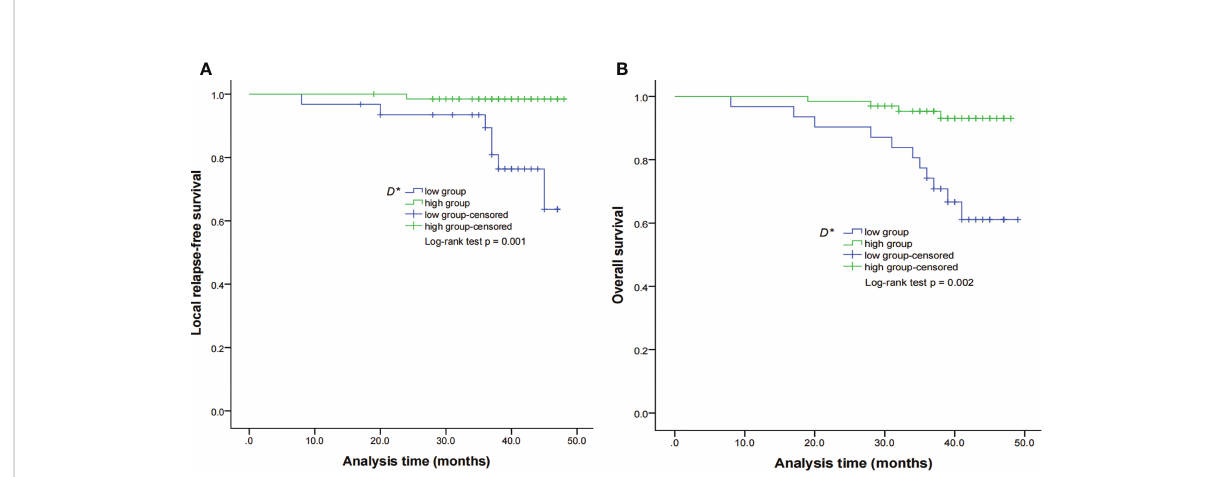
FIGURE 4 Kaplan – Meier curves of LRFS (A) and OS (B) for NPC patients strati fi ed as the low D* and high D* groups. Low D* group = patients with a primary lesion pretreatment D* value ≤ 8.71 × 10 − 3 mm 2 /s; high D group = patients with a primary lesion pretreatment D value > 8.71 × 10 − 3 mm 2 /s. NPC, nasopharyngeal carcinoma; D*, pseudo-diffusion coef fi cient; LRFS, local relapse-free survival; OS, overall survival.